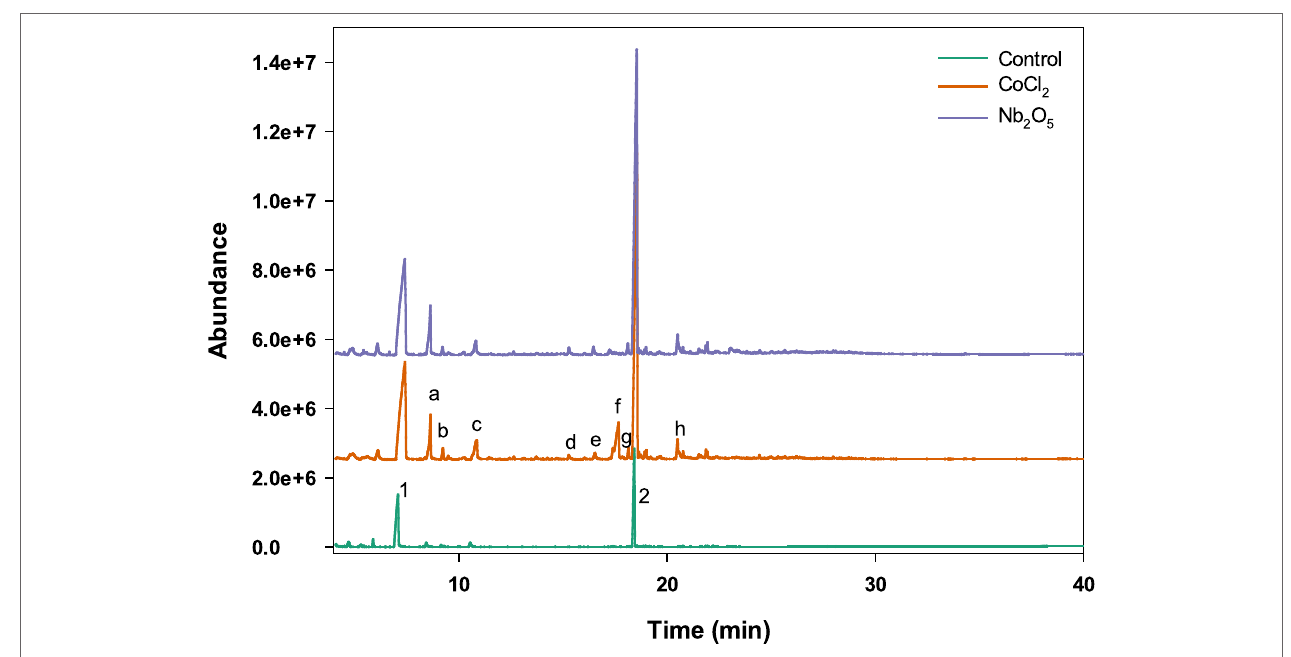
FigUre 2 | Representative GC chromatography [peaks representing a: guaiacol, b: 4-methoxy-1,3-benzenediamine, c: 1,3,5-benzenetriol, d: syringol, e: vanillin, f: 1-methyl-4-thiouracil, g: acetovanillone, h: homovanillic acid, 1: 1-ethyl imidazole, and 2: butylated hydroxytoluene (stabilizer for MeTHF)]. Experimental conditions: temperature: 120°C, catalyst loading: 1%, and H 2 O 2 concentration: